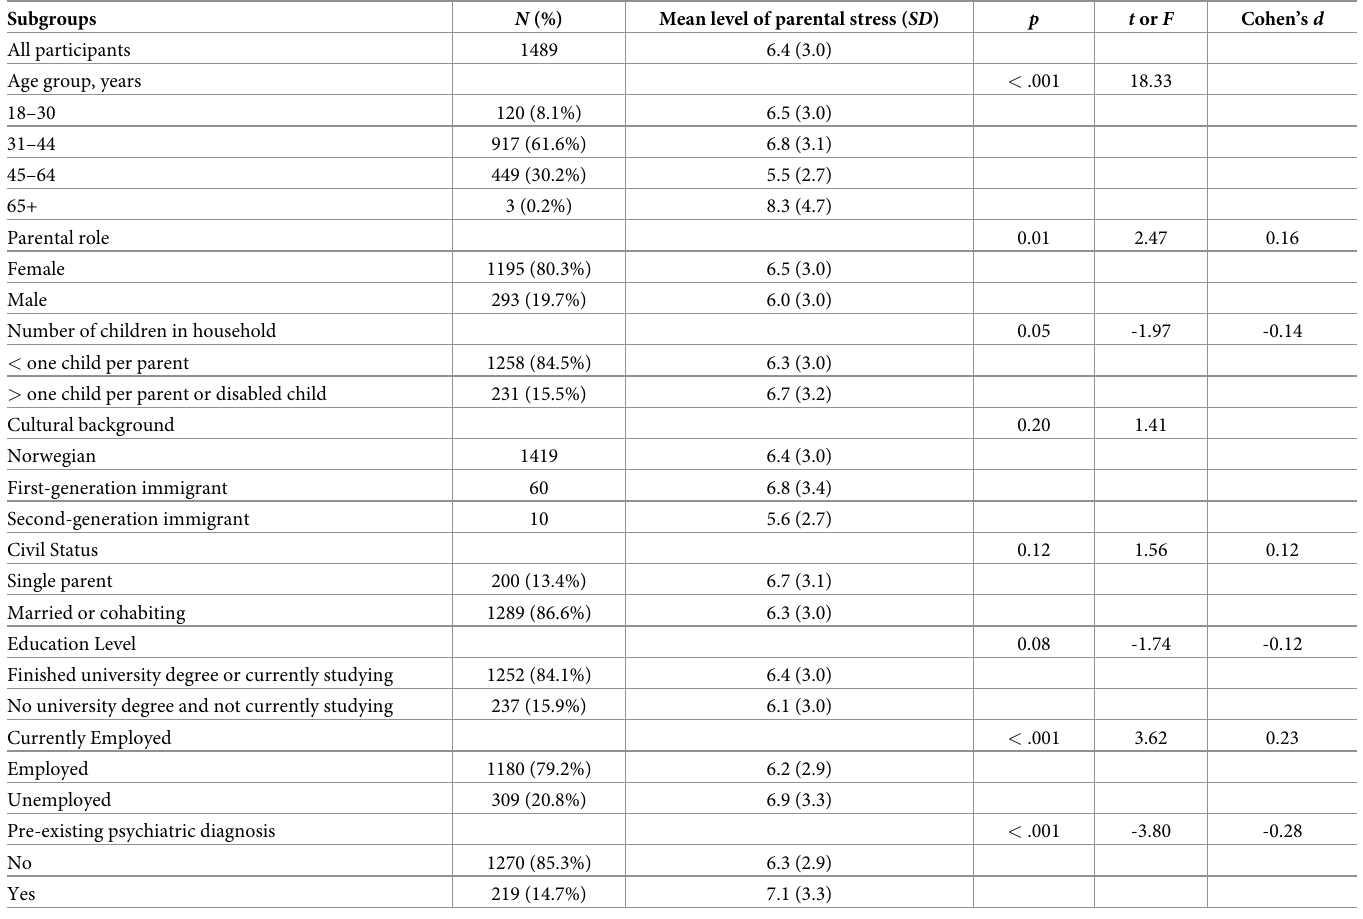
Table 3. Demographic information of the participants at T2 and mean level of parental stress in each